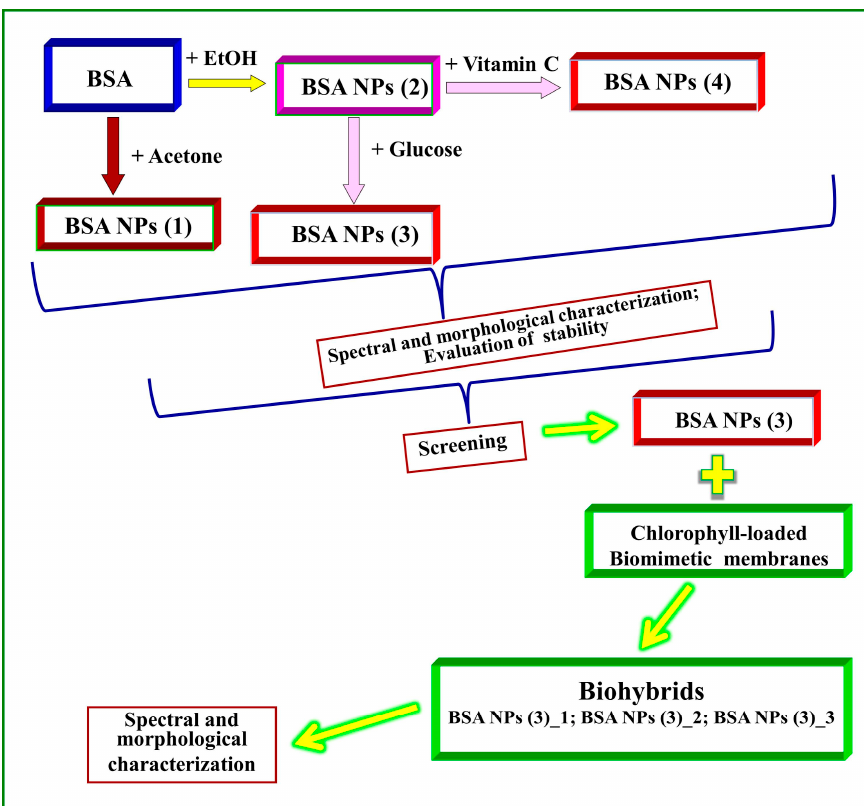
Figure 2. Schematic representation of the preparation of albumin particles at room temperature (RT), using acetone (BSA NPs(1)) or EtOH (BSA NPs(2)) as desolvating agents [31]. Two types of eco-friendly crosslinkers were used: glucose (BSA NPs(3)) and ascorbic acid (vitamin C) (BSA NPs(4)). After preparation, the stability evaluation and spectral and morphological characterization were performed.